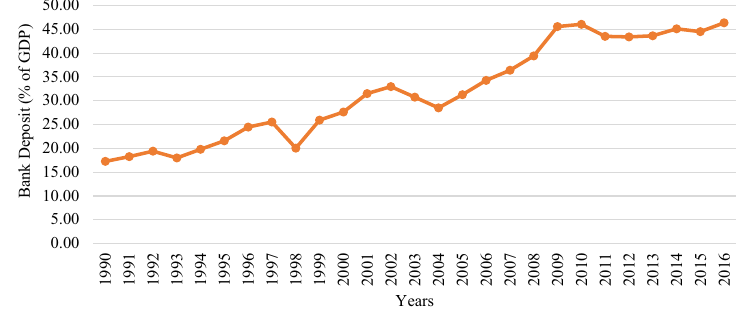
Figure 1. Bank deposits (% of GDP) 1990 –